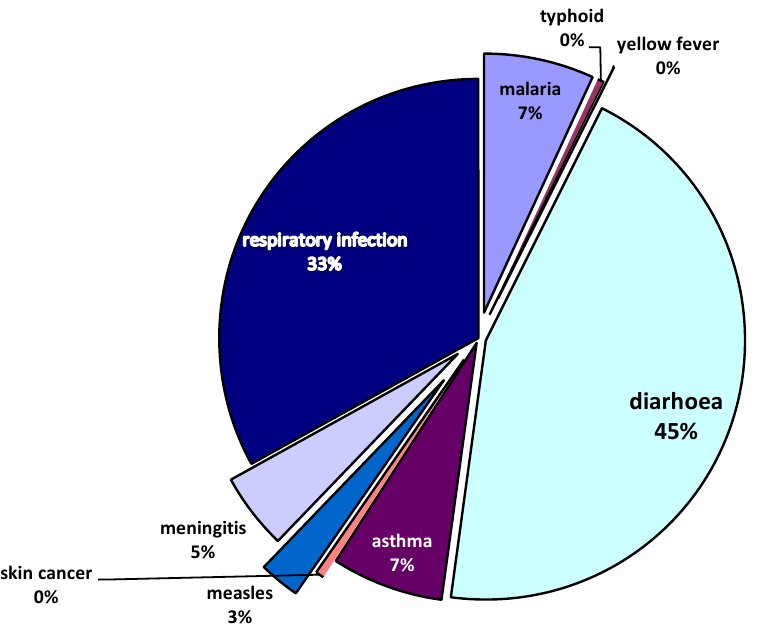
Figure 4. Types of diseases.